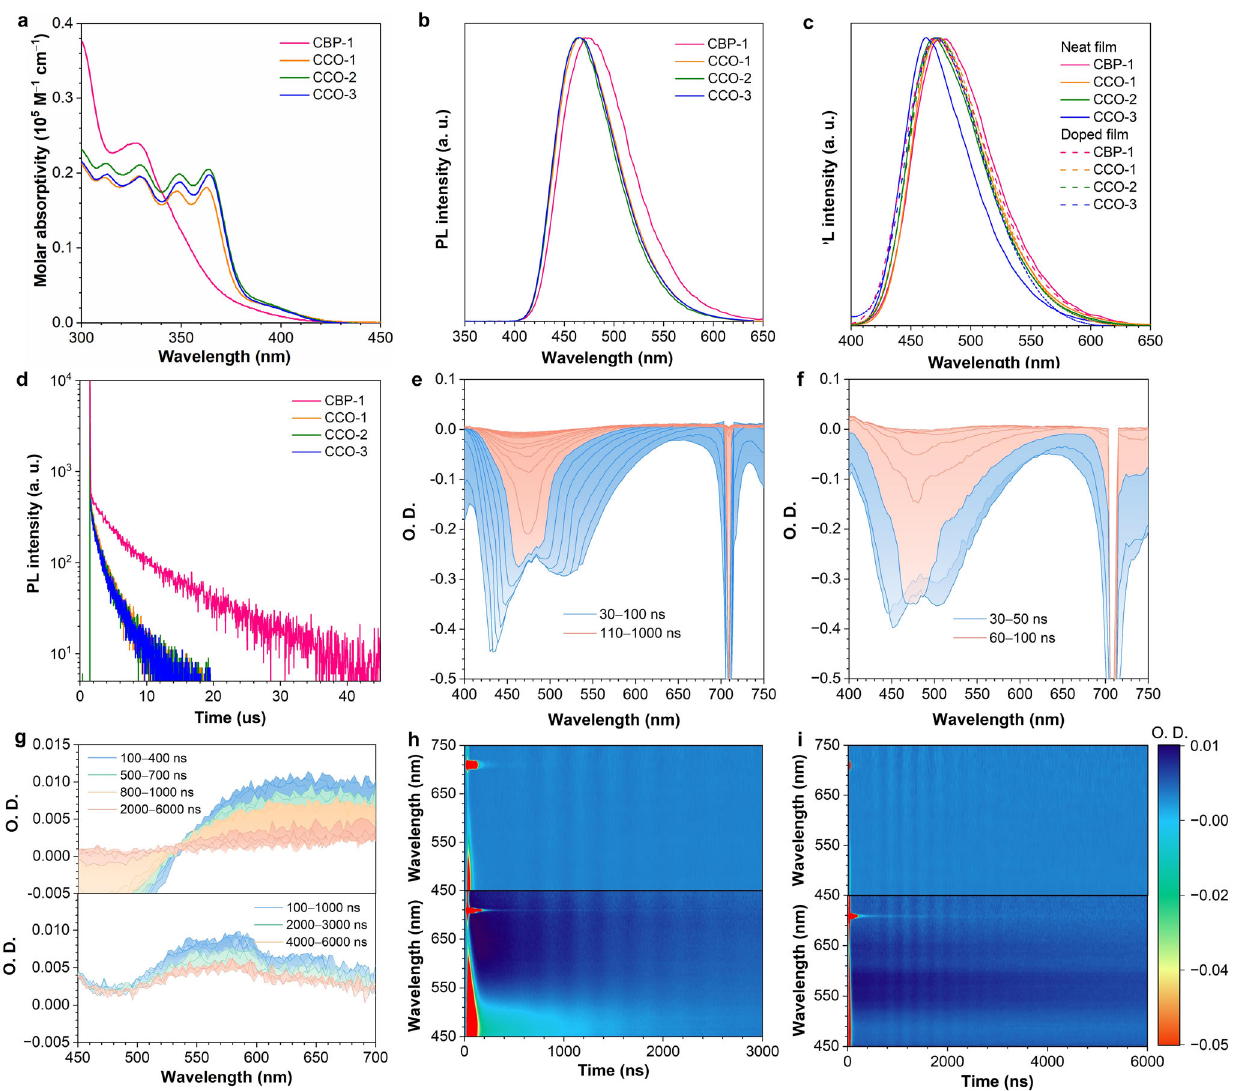
Fig.3 |Photophysicalcharacterization.a Absorptionspectraand b PLspectrain toluene solutions (10 − 5 M). c PL spectrain neat fi lms (solid line) and 20wt%doped fi lms(dashline). d Temperature-dependentPLdecaycurvesof20wt%doped fi lms, measured under nitrogen. Transient absorption spectraof e CCO-1 and f CBP-1 on nanosecond timescales in oxygen-free toluene solutions (10 − 5 M). Excitation